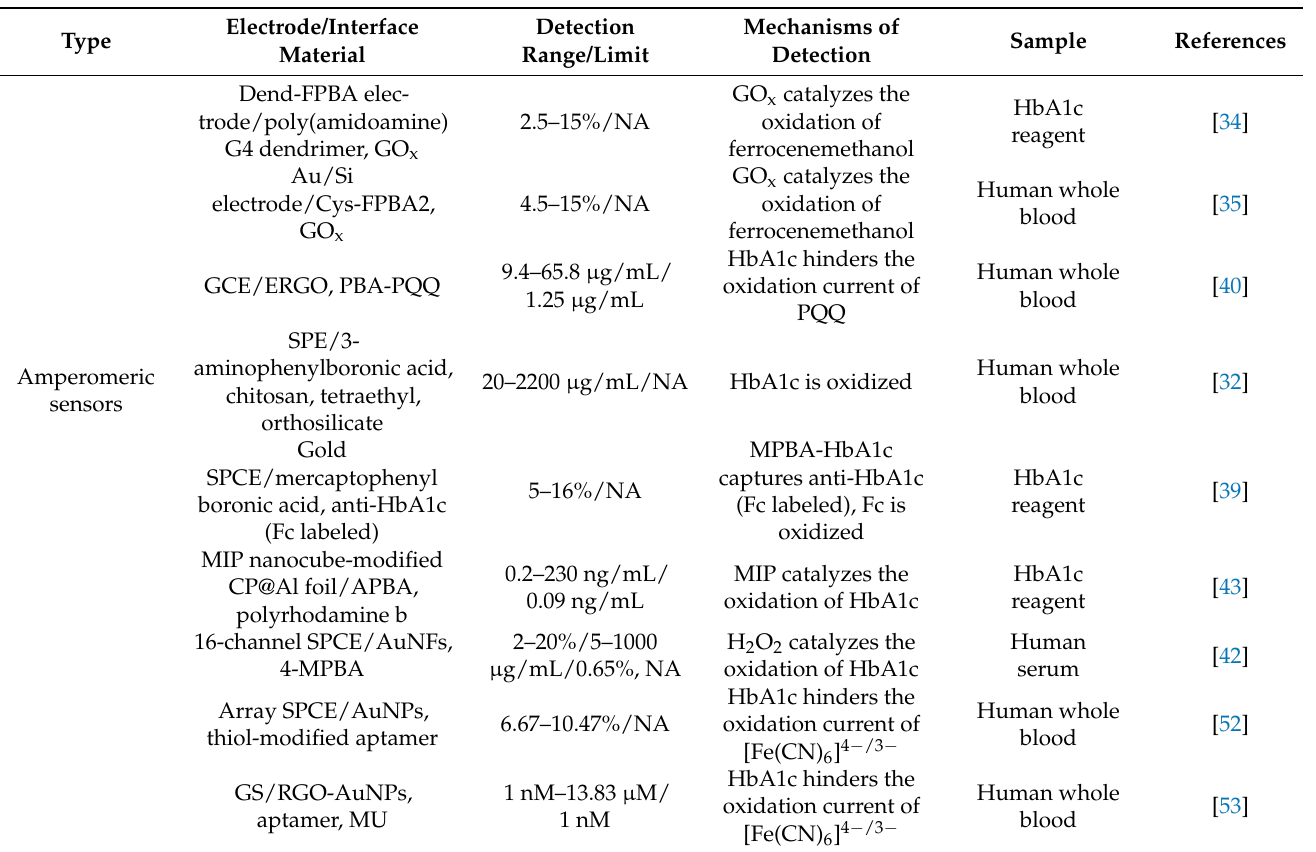
Table 1. Direct type electrochemical HbA1c